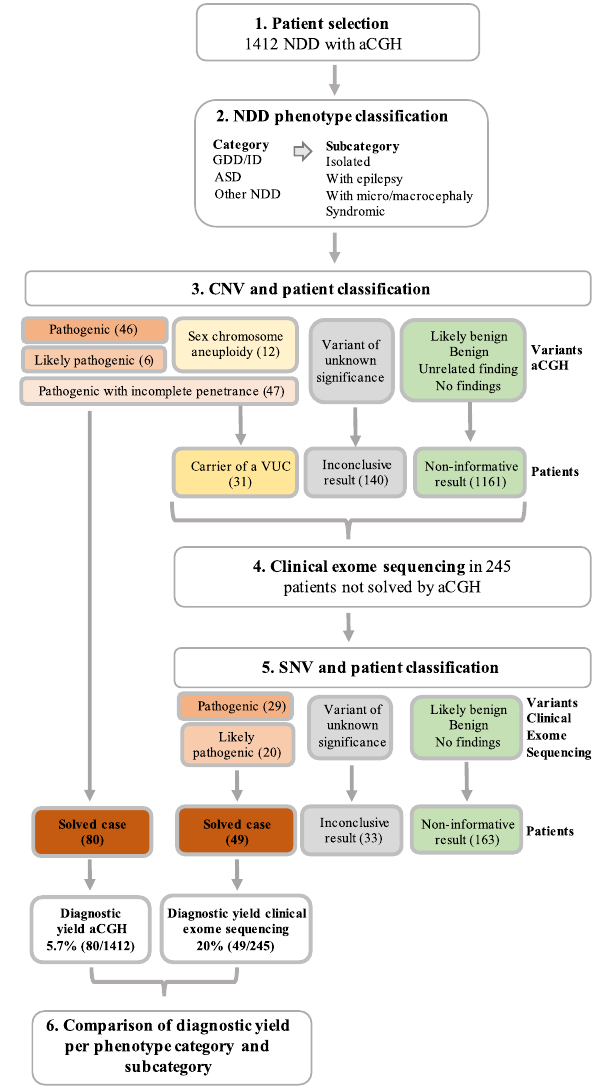
Fig. 1 Flow chart of the process followed in this study. One thousand four hundred and twelve NDD patients with aCGH data were selected and phenotype was classi fi ed into three categories: GDD/ID, ASD, and Other NDDs; and four subcategories: isolated forms, forms with epilepsy, forms with micro or macrocephaly, and syndromic forms. CNVs identi fi ed by aCGH were classi fi ed into seven different classes according to the pathogenicity and patients carrying such variants were subsequently classi fi ed into four different categories: solved patients, carriers of a variant with unclear contribution, patients with inconclusive results and patients with non-informative results. Two hundred and forty- fi ve unsolved patients were further subjected to clinical exome sequencing; SNVs classi fi ed into the fi ve ACMG classes, which were translated into three different patients ’ categories. Diagnostic yield, expressed as the percentage of solved cases, by aCGH and clinical exome sequencing was